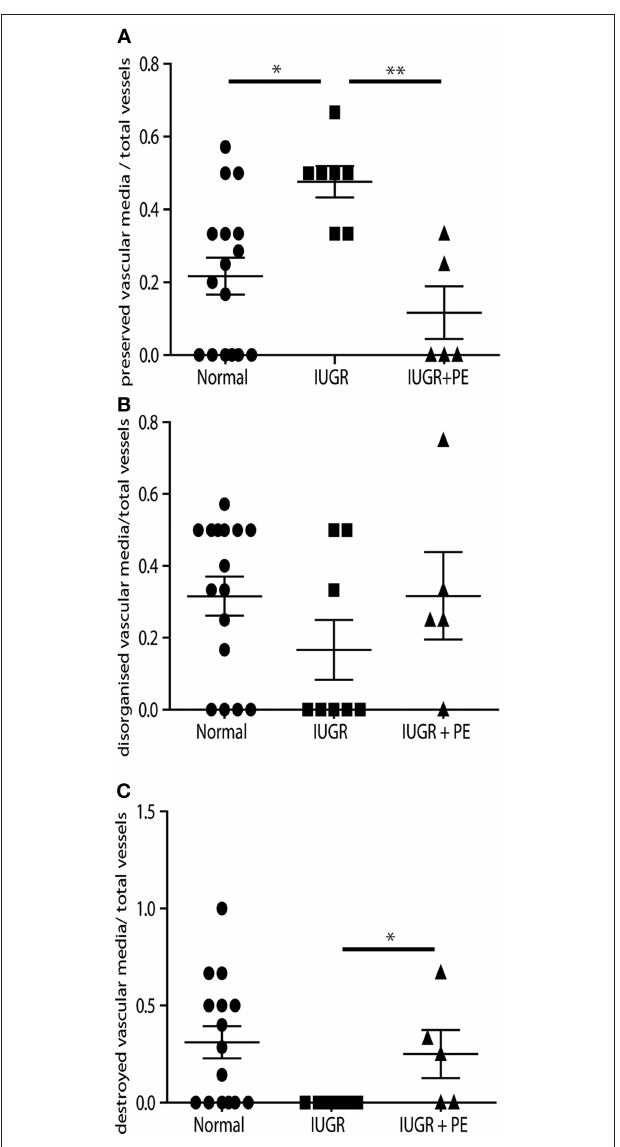
FIGURE 2 | IUGR PBBx display high numbers of preserved uterine spiral arteries. Graphs show quantitation of the degree of remodeling of all myometrial vessels control (circle), IUGR (square) and IUGR with preeclampsia (triangle) groups. Preserved vessels were scored when intact multi layered vascular smooth muscle media was present (A) . Disorganized vessels were scored when the vascular media was separated and smooth muscle cells were migrating away from the outer layers of the media (B) . Destroyed vessels were scored when all media had been lost and replaced with fibrin (C) . * p < 0.05, ** p < 0.01.